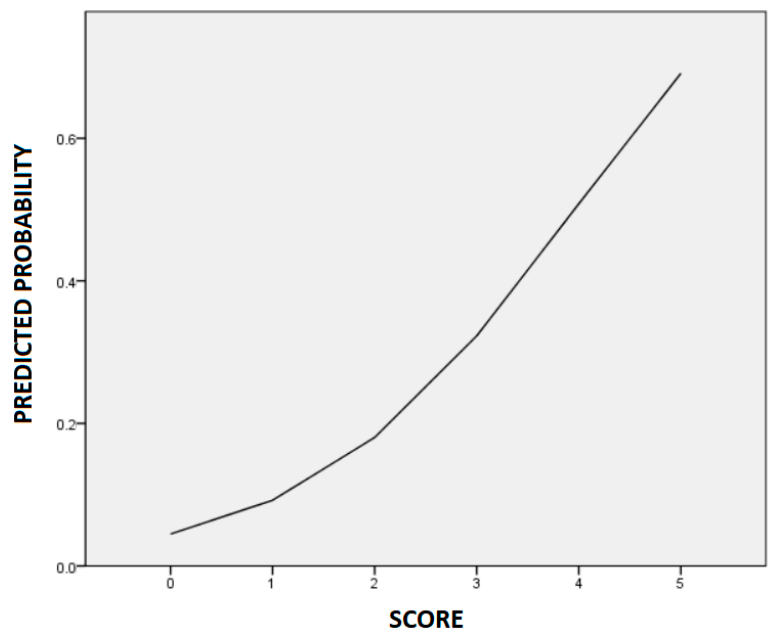
Figure 2. The logistic regression curve of the predicted probability of ritodrine-induced adverse events.